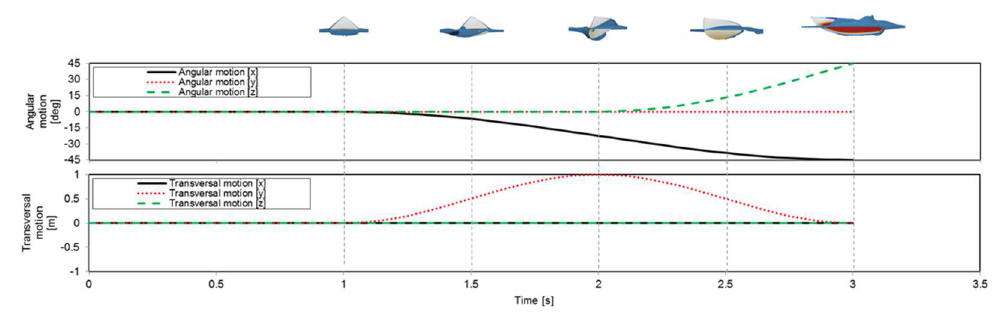
Figure 5. Imposed motion in the maneuvering